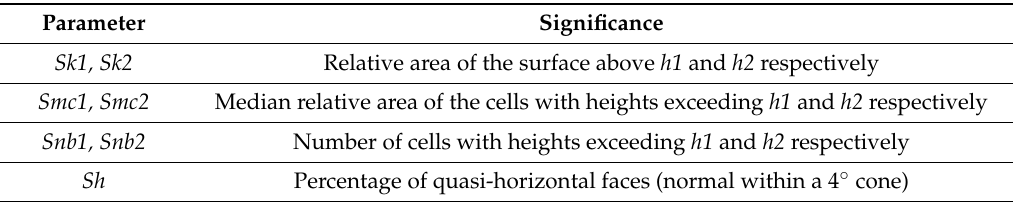
Table 3. Topological